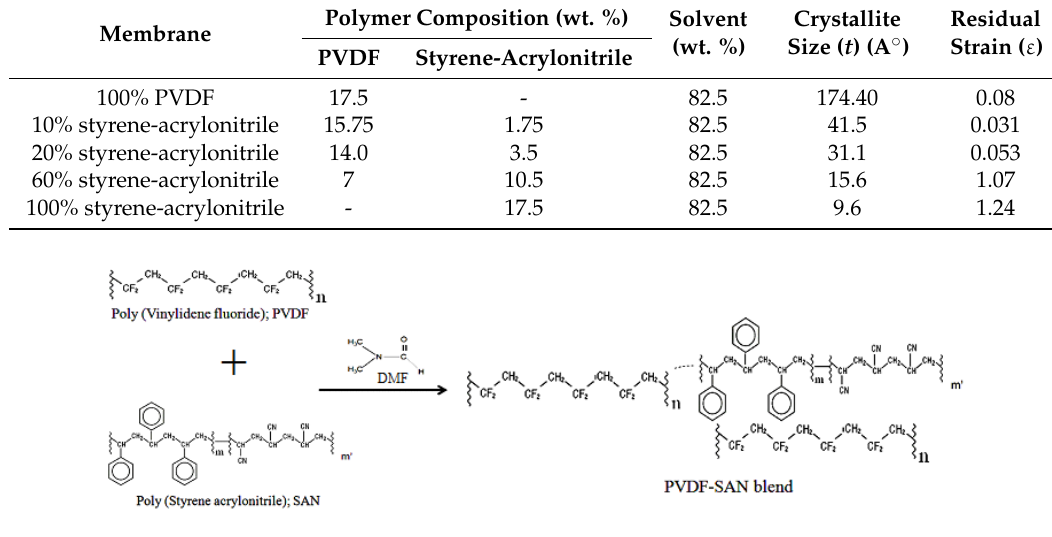
Figure 2. Schematic diagram of surface modification of the PVDF membrane. 2.3. Membrane Characterization The XRD studies of the various polymer blend membranes were performed on an X ‐ Ray diffractometer (model ULTIMA III) from RICAGU, Tokyo, Japan. XRD patterns provide comprehensive structural information related to the materials. The XRD patterns of the membranes were studied, and their crystallite size and residual strain were analyzed using the Williamson ‐ Hall equation (Equation(1)) [17].The crystallinity data is given in Table 2. β cos θ (cid:3404) 4ϵ sin θ (cid:3397) (cid:1837) (cid:3400) λ (cid:1872)